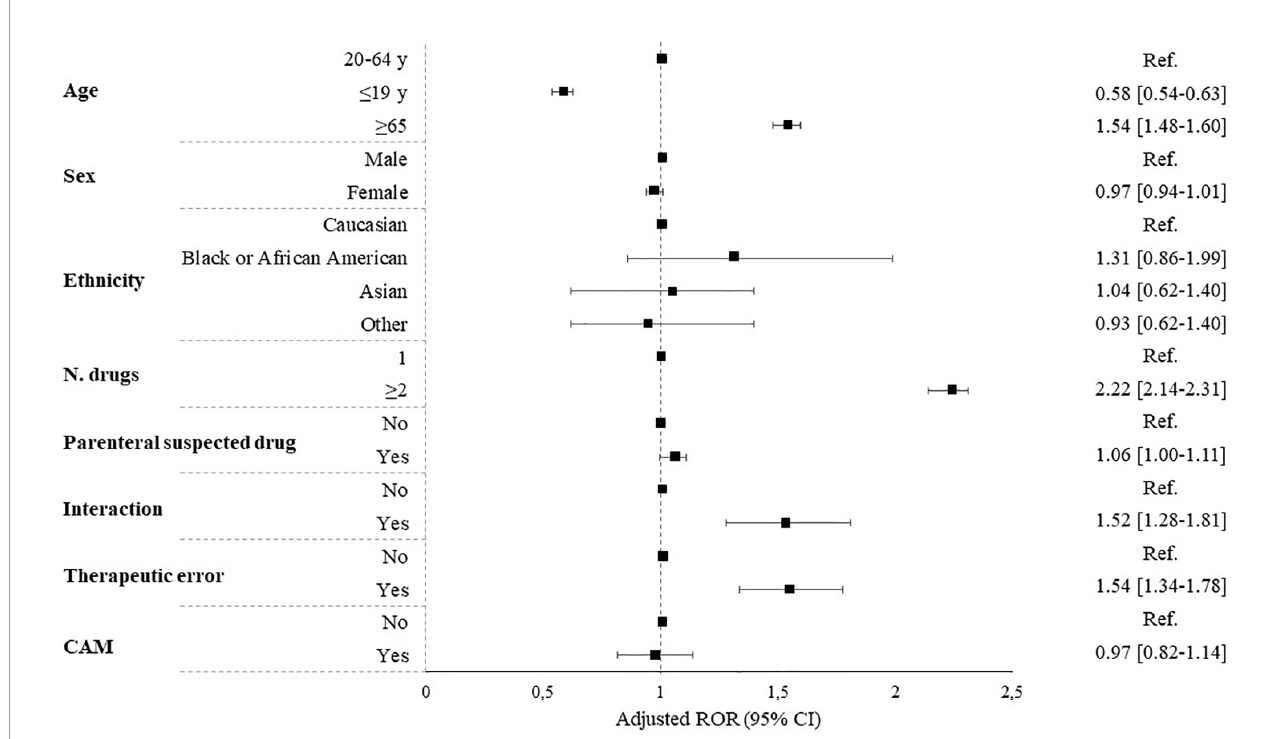
FIGURE 1 | Predictors of hospitalization expressed as reporting odds ratio (ROR). CAM, complementary and alternative